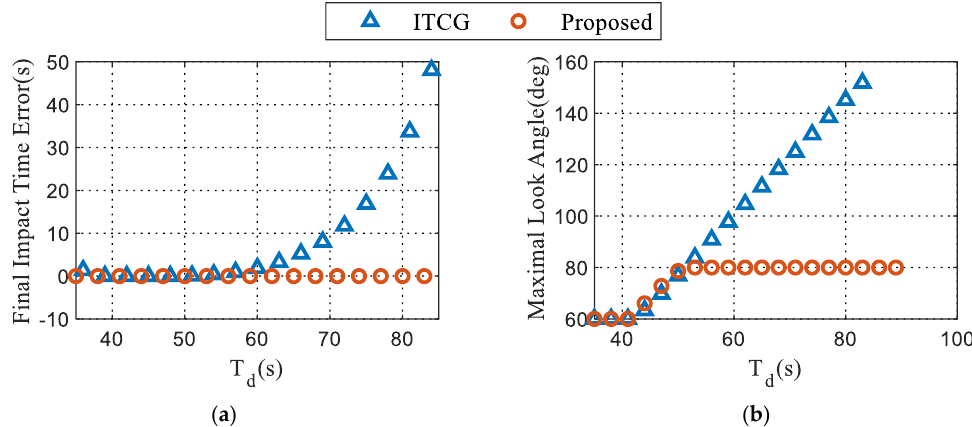
Figure 17. The comparison results. ( a ) Final impact time error; ( b ) Maximal look angle. For